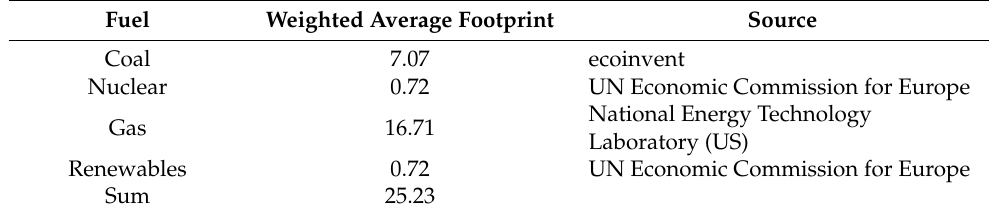
Table 4. Pre-combustion footprints, US electricity (lb CO 2